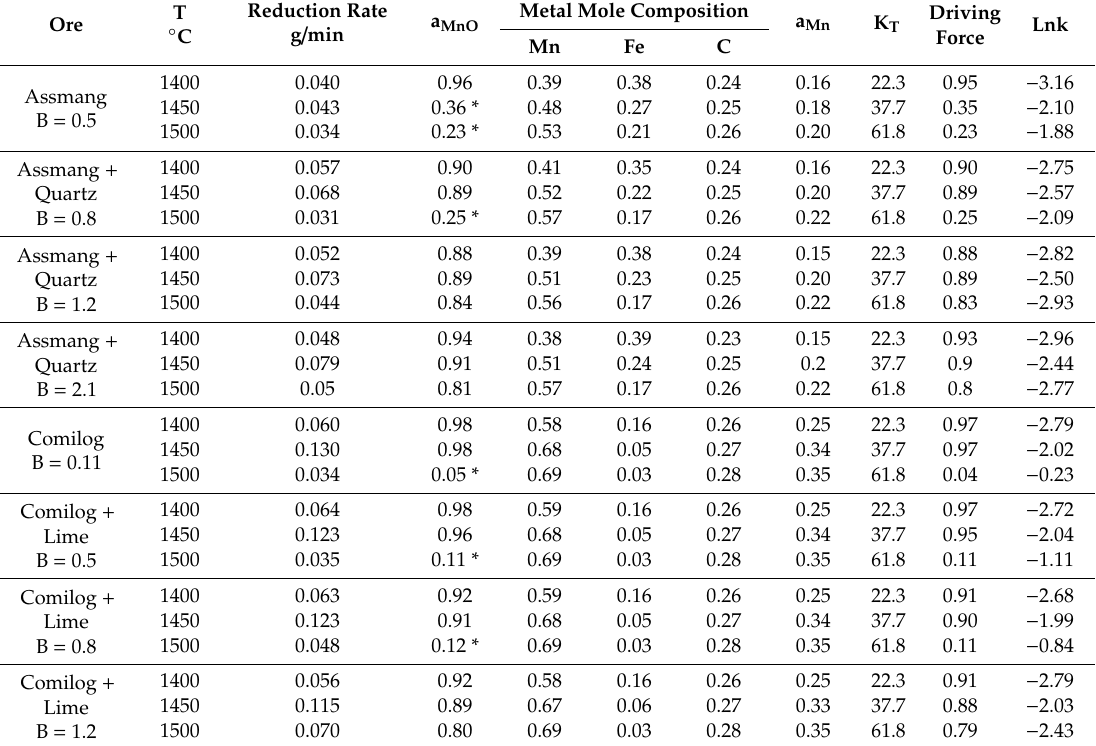
Figure 4. Calculated %MnO in the slag versus temperature from all experiments. ( a ) Assmang series; ( b ) Comilog series.